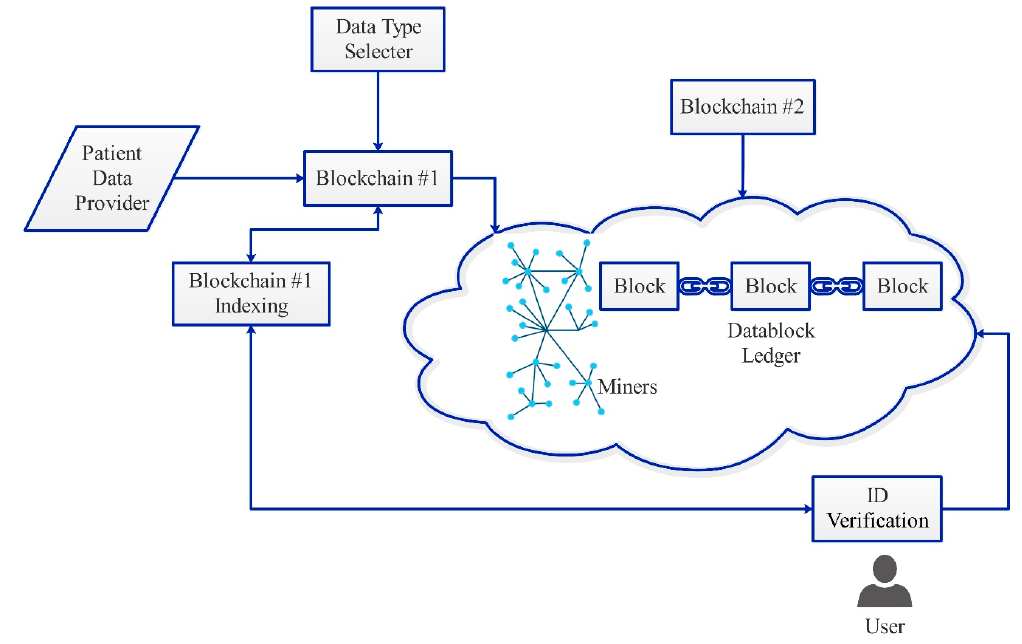
Figure 4. The proposed scheme structure.